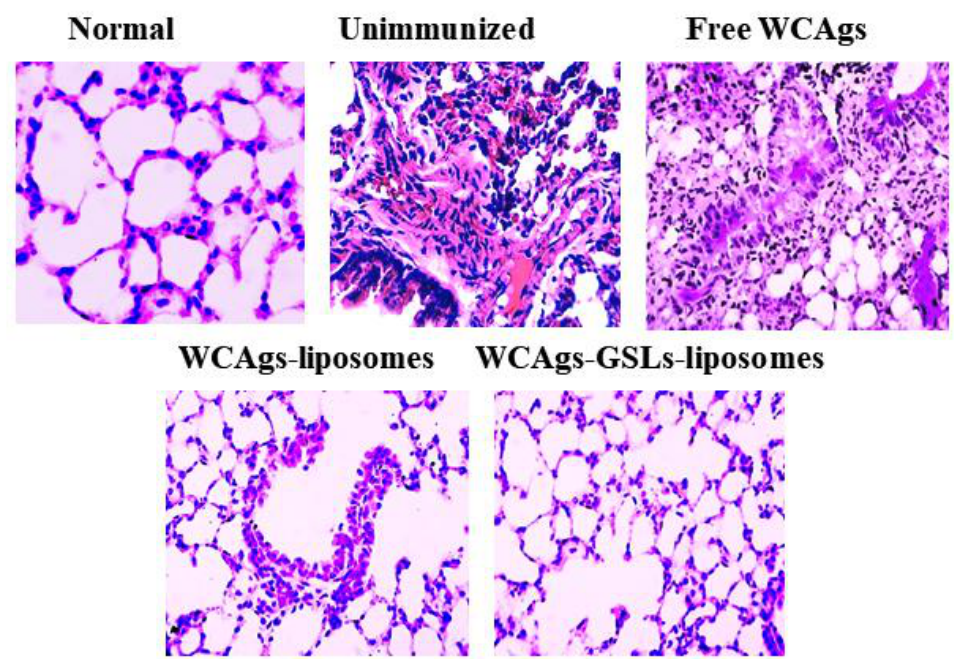
Figure 9. The immunocompromised mice vaccinated with WCAgs‑GSLs‑liposomes showed highly improved structural integrity in their lung tissues, as compared to the lung tissues from the unim- munized or free WCAgs- or WCAgs-liposomes-immunized mice.